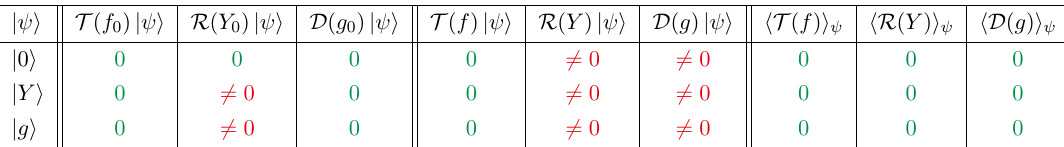
Table 5 . Action of the charges (3.2) on the vacuum state | 0 i and the states | Y i = e − i R ( Y ) | 0 i and | g i = e − i D ( g ) | 0 i . The first three columns correspond to the charges (4.1) that generate ordinary conformal transformations. By “ 6 = 0 ” we mean the state is not an eigenstate of the charge, but it has a non-trivial